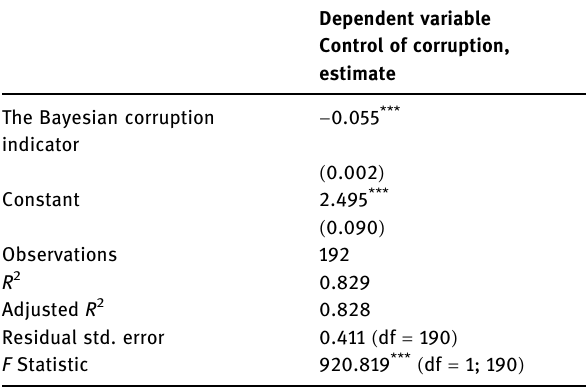
Table 2: Regression results: The Bayesian Corruption Index against control of corruption